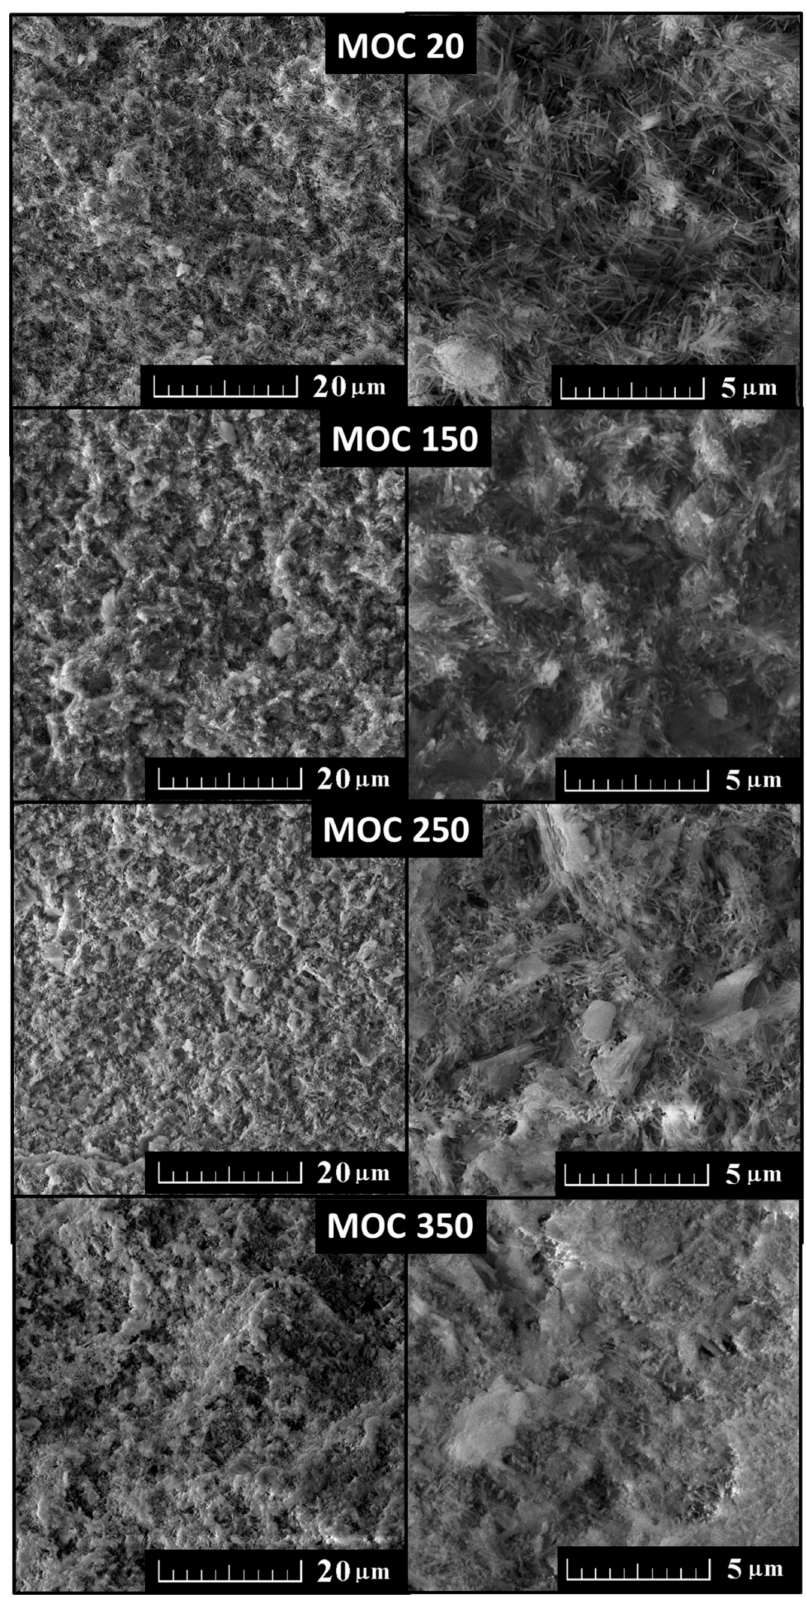
Figure 11. SEM micrographs (fracture surface) of MOC 20, MOC 150, MOC 250, and MOC